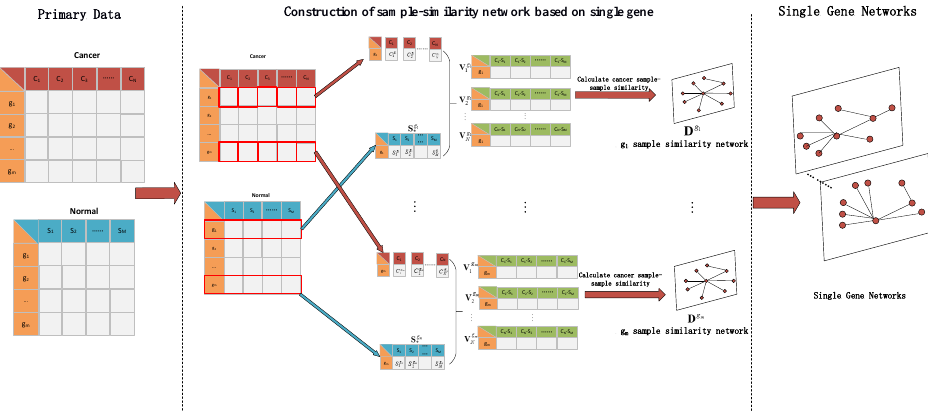
Figure 2. The process for constructing a similarity network of a single gene